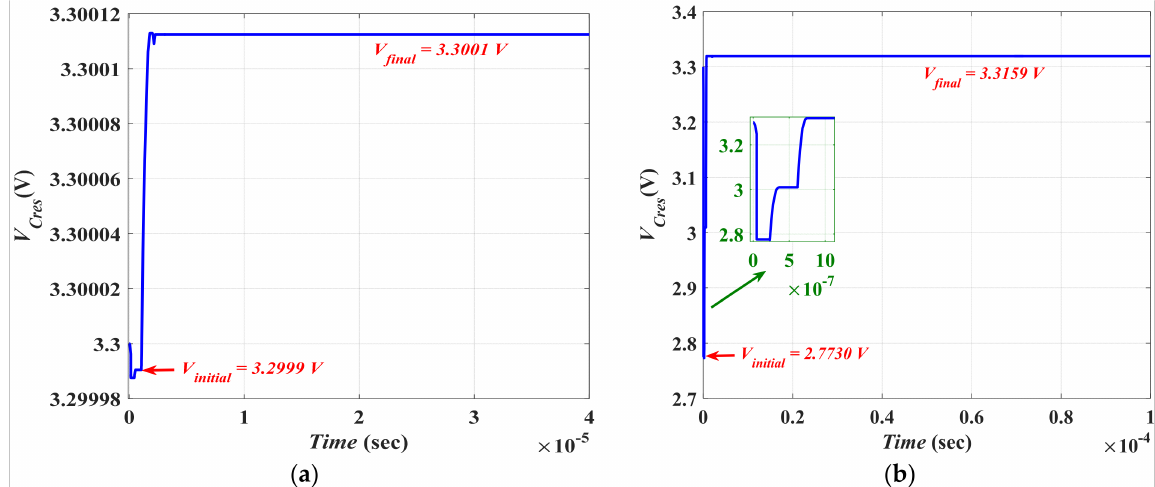
Figure 15. The reservoir capacitor voltage ( a ) for the simulated converter ( b ) for the fabricated